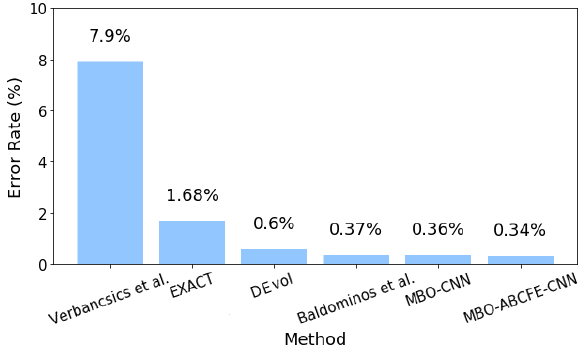
Figure 8. Visual representation of the comparative